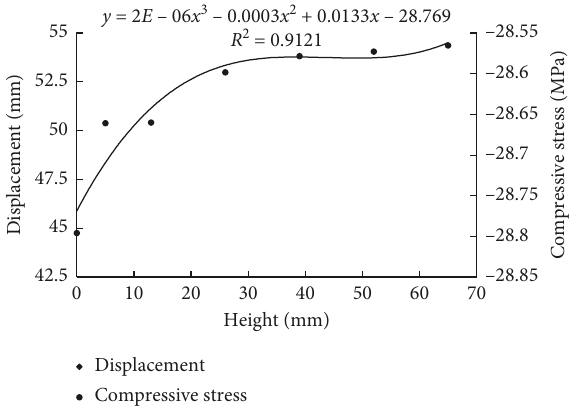
Figure 8: AU-T height-displacement/compressive stress